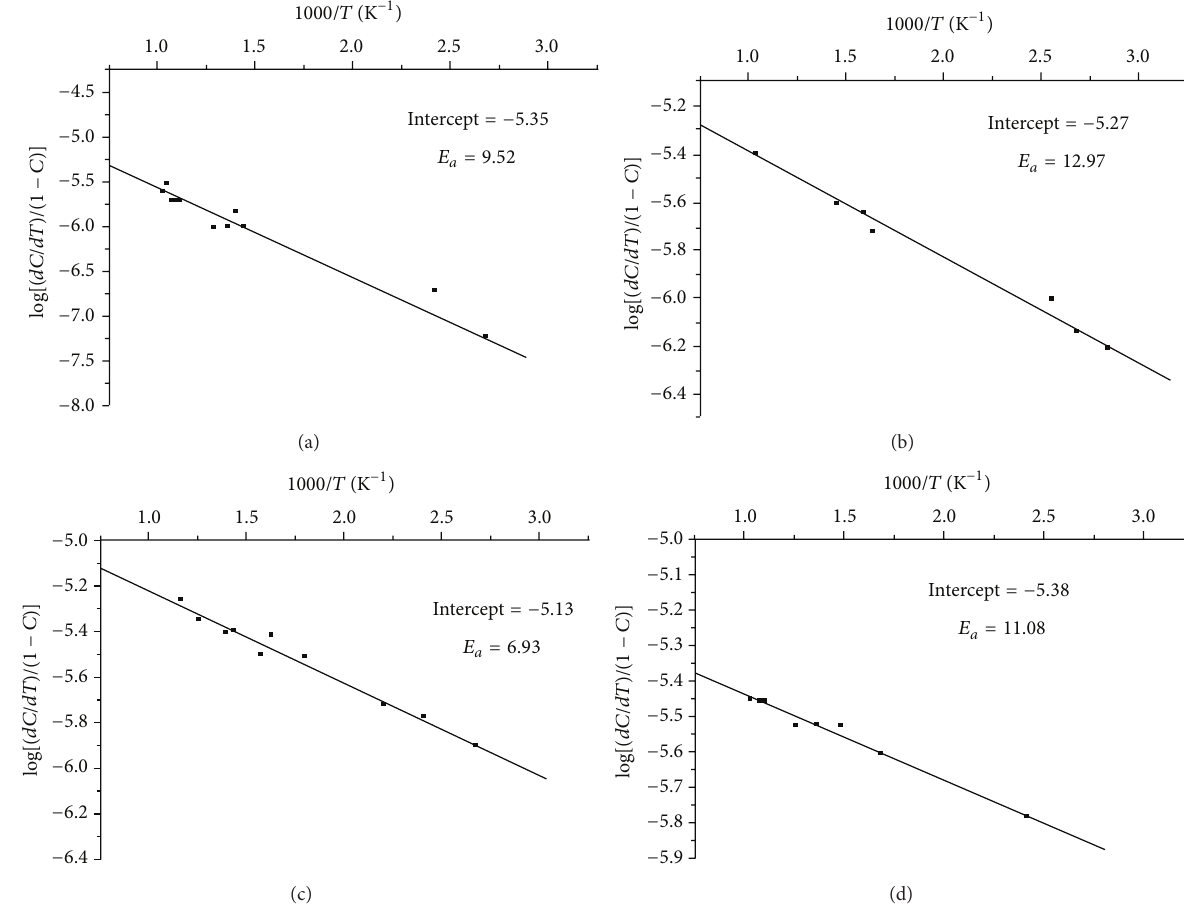
Figure 10: Sharp-Wentworth plots of (a) BEF ligand, (b) BEF–Cu, (c) BEF–Ni, and (d) BEF–Zn. Table 5: Kinetic and thermodynamic parameters